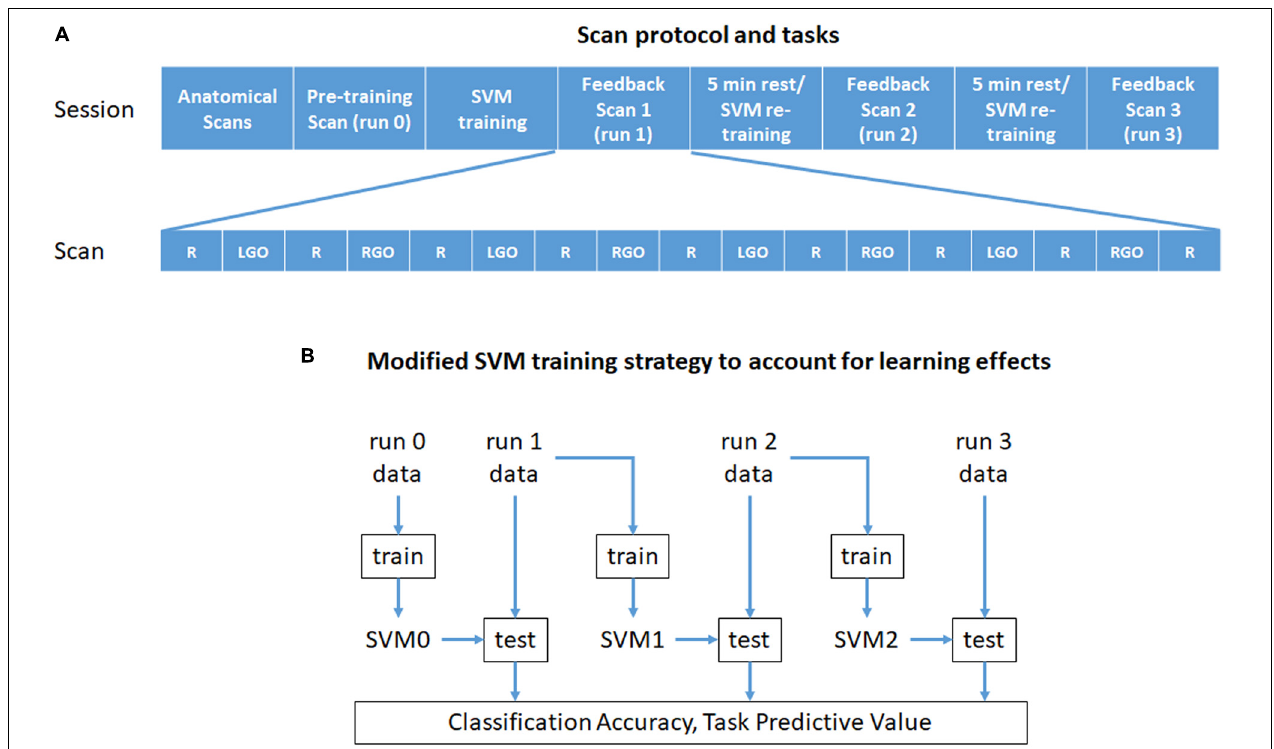
FIGURE 1 | Outline of (A) the experiment protocol and tasks and (B) the modified training strategy used in this study. Each scan block in (A) is 30 s long. R, rest; LGO, imagined left hand gripping and opening; RGO, imagined right hand gripping and opening; SVM, support vector